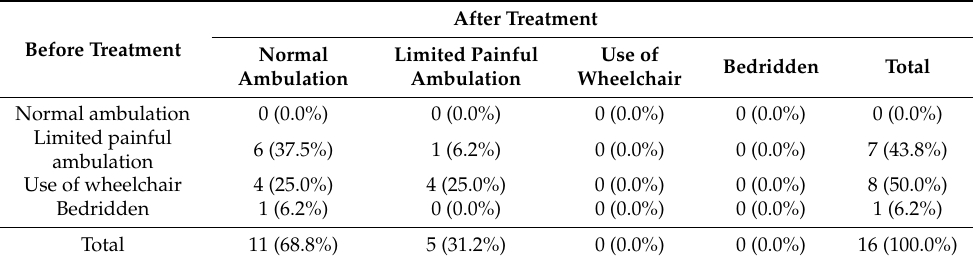
Table 2. Between walking performance rated on the Functional Mobility Scale (FMS) and measures of walking capacity after the